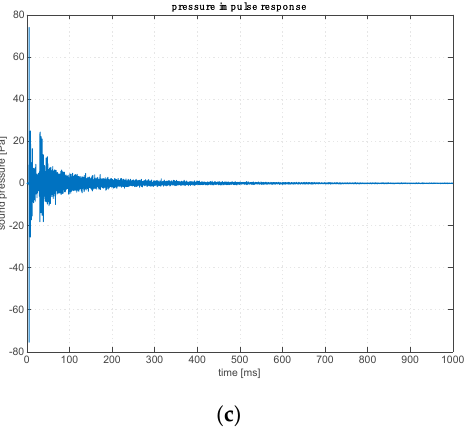
Figure 9. Conditions for measuring and the pressure impulse response of a sample room; ( a ) view of sample room; ( b ) dimensions of measurement setup; ( c ) standard pressure impulse response of the room.